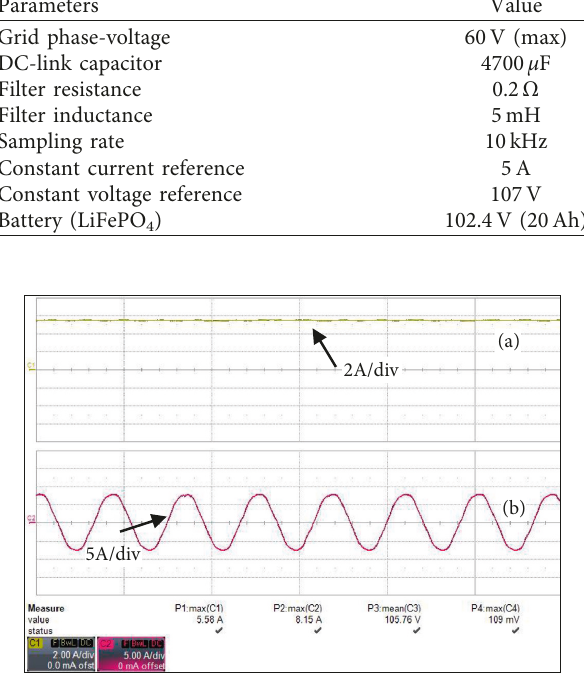
Figure 15: Experimental results of (a) battery current and (b) phase-A grid current in CC mode.